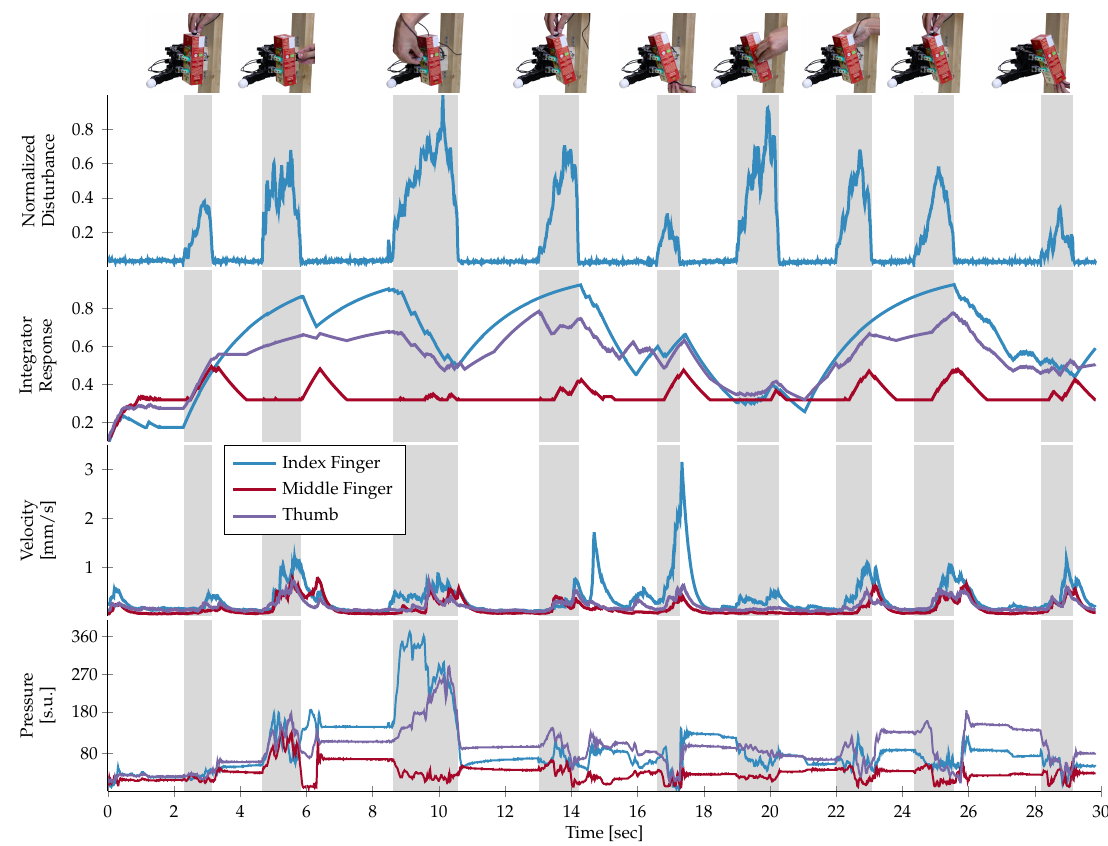
Figure 6. The magnitude of the external perturbations (top panel), the resulting integrator responses (second panel), changes in fingertip positions (third panel), and the fingertip pressures (bottom panel) during a full 30 second experimental run. Early pressure changes represent the initial stabilization of the object in-hand. Subsequently, the individual fingertip pressures dynamically and independently change and the integrator response increases every time that the object was perturbed by the experimenter (top panel), or, interestingly, by ’spontaneous’ changes in individual fingers (e.g., around 17